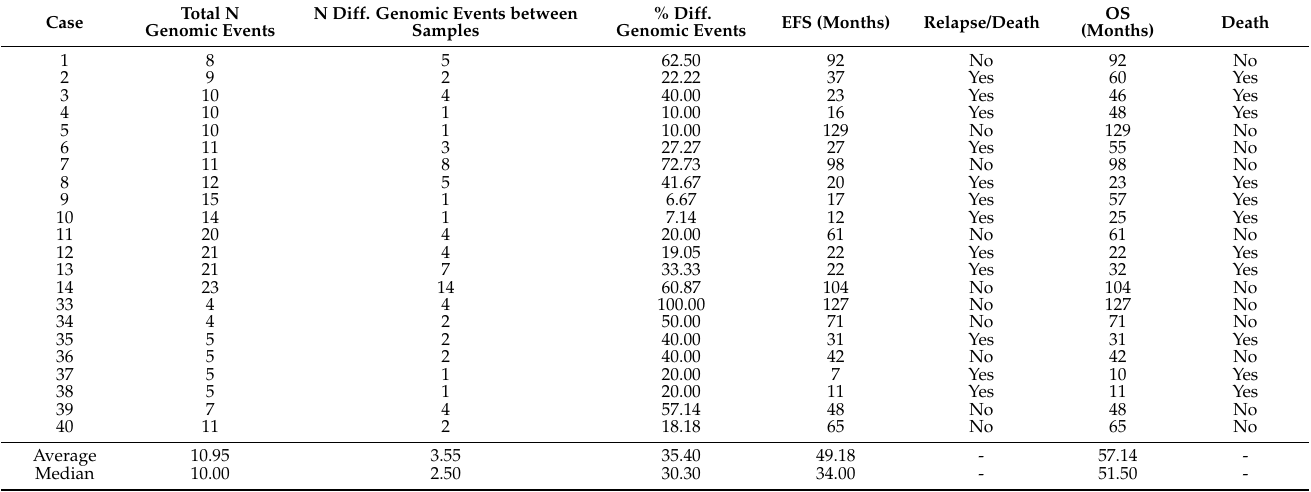
Table 2. Genomic events and survival data in intra-tumour heterogeneous (ITH) cases. Cases with high ITH (with 50% or more of genomic events different between the analysed samples) are